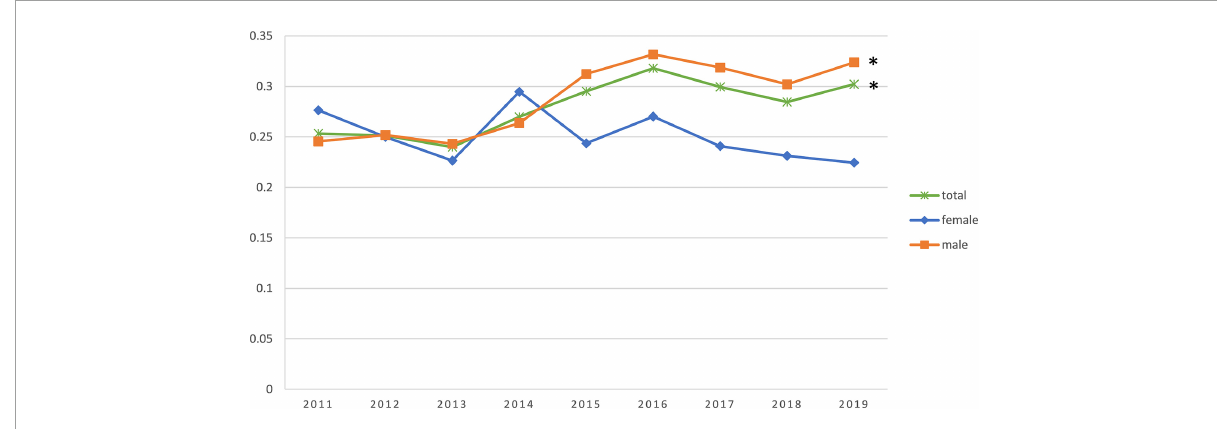
FIGURE1 Trends in the percentage change of young patients in the annual acute myocardial infarction (AMI) incidence. ∗ The difference is statistically